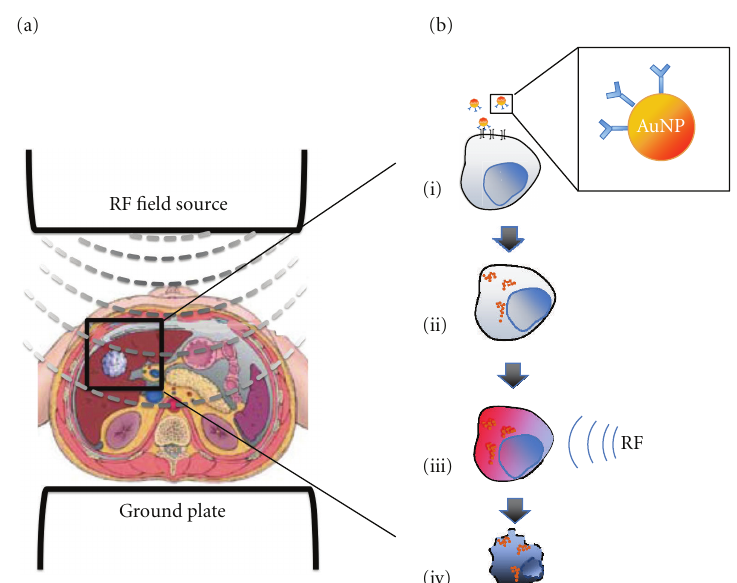
Figure 1: Principle of the non-invasive RF based treatment of HCC. A. RF field source is used to generate a uniform low frequency electromagnetic field that penetrates tissues and reaches the tumor. B. Nanoparticles that can be thermally activated are conjugated to monoclonal antibodies against known targets expressed on HCC (i), internalized specifically by cancer cells after systemic administration (ii), and upon RF activation release heat (iii) causing targeted cancer cell death.